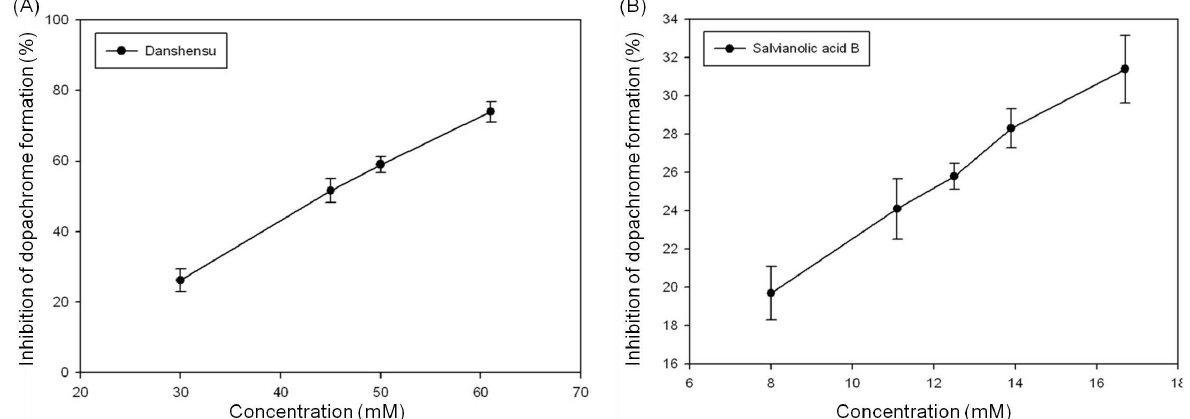
Figure 5. The inhibition effects of ( A ) danshensu and ( B ) salvianolic acid B on tyrosinase activity. Each value represents the mean ± SE ( n =